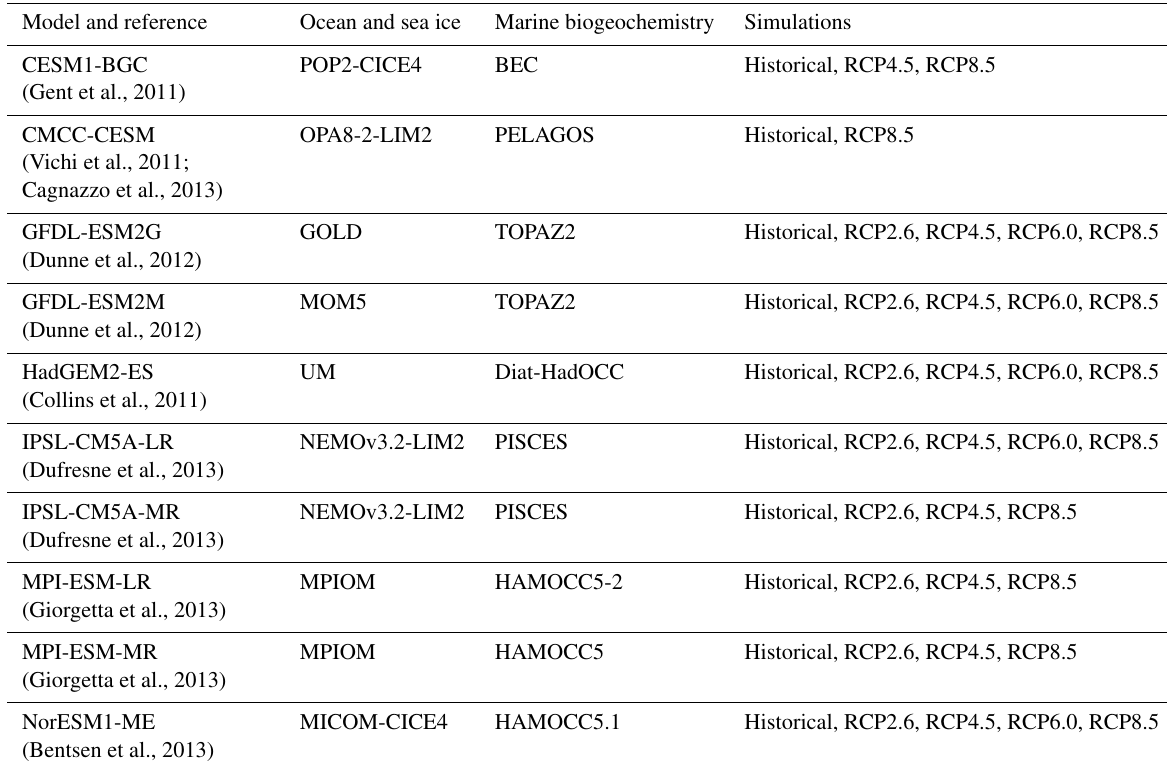
Table 2. The CMIP5 Earth system models used in this study; their individual components used to represent ocean, sea ice, and marine biogeochemistry; and the simulations that were assessed. All models provided temperature, pH, oxygen, nitrate, and NPP outputs, as in Bopp et al.